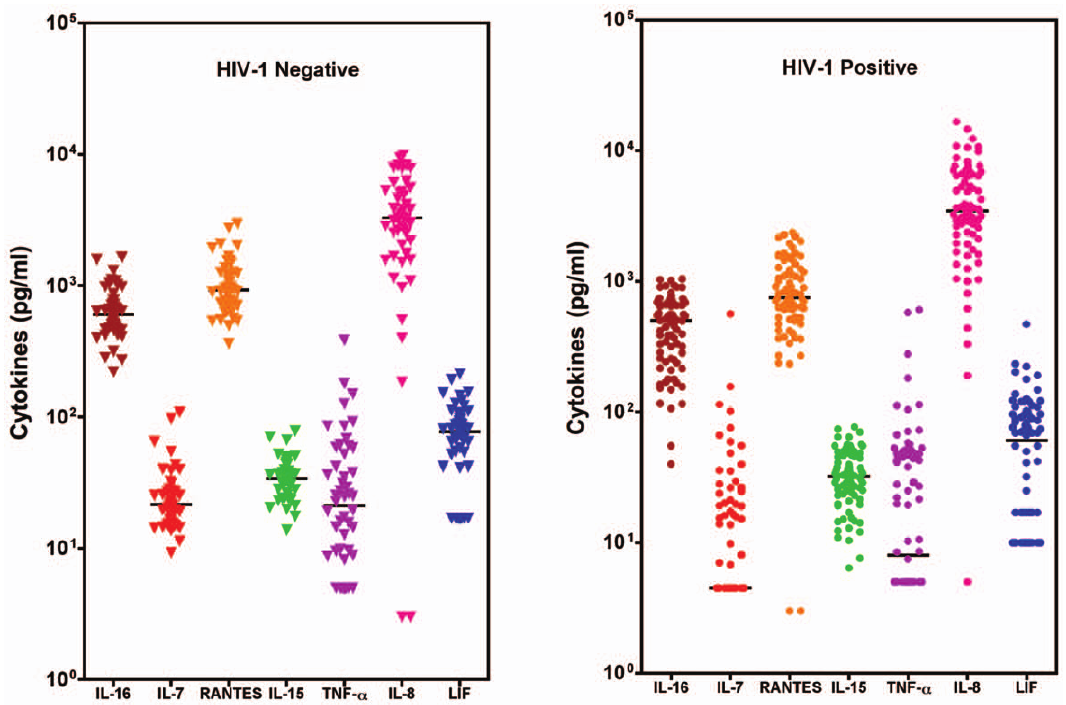
Figure 2. Cytokine protein secretion in the culture supernatant after a 24 hour explant culture of placenta of HIV-1 negative (left panel) and positive (right panel) women. Placental fragments were cultured for 24 hours after which culture supernatants were harvested. Cytokines were quantified in the supernatants using commercially available ELISA kits. Each dot represents one individual placenta and the horizontal bar, the median value. A total number of 50 placentas for HIV-1 negative and 80 for HIV-1 positive women were tested for each cytokine. For IL7, TNF- a , IL-8 and LIF, the lowest values correspond to the assay detection limit. Comparisons between the 2 groups were performed through Mann- Whitney